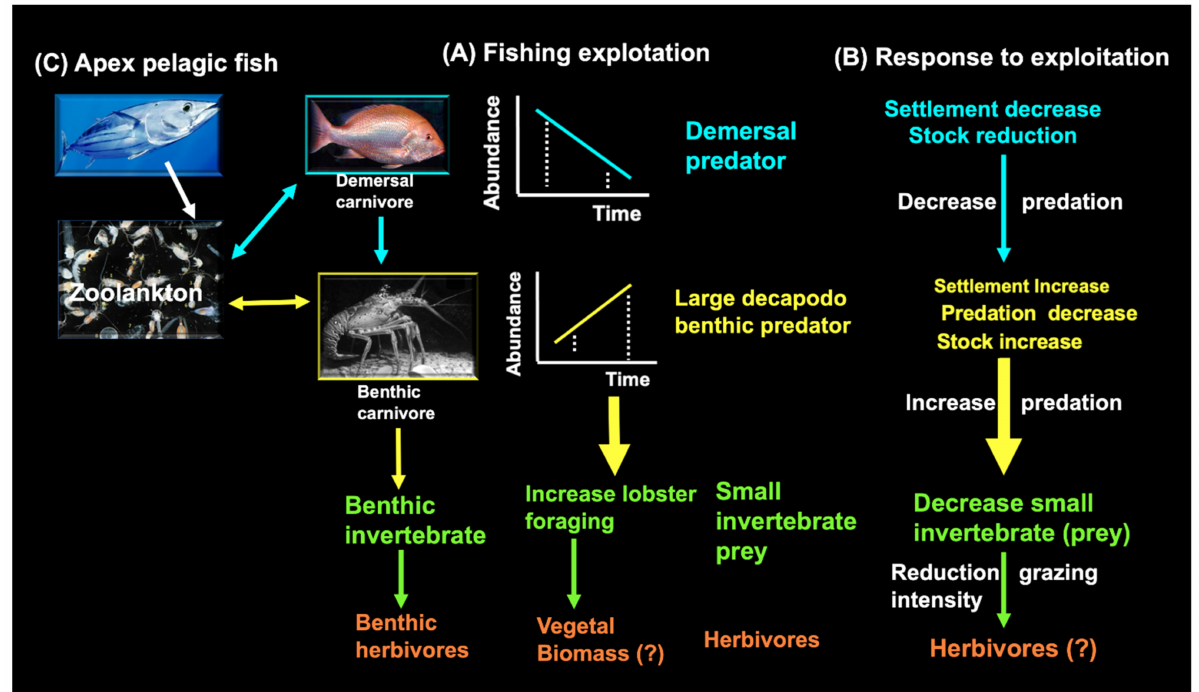
Figure 13. Theoretical model of top-down control. ( A ) Fishing exploitation of top predators (demersal carnivore) and red spiny lobster (benthic keystone) on continental shelf of Brazil (CSB). Decreasing production (abundance) of demersal predator (snapper) leads to increased prey abundance (see Figure 11). ( B ) Response to exploitation. The decreasing abundance of the demersal predator populations leads to reduce predation on the prey (red spiny lobster), which in turn leads to an increase in abundance and increased predation in small invertebrate (prey). ( C ) Apex pelagic fish. The increase of predation on zooplankton, leads to a decrease the abundance of larval recruitment. Thick arrows represent strong trophic interactions; thin arrows represent weak